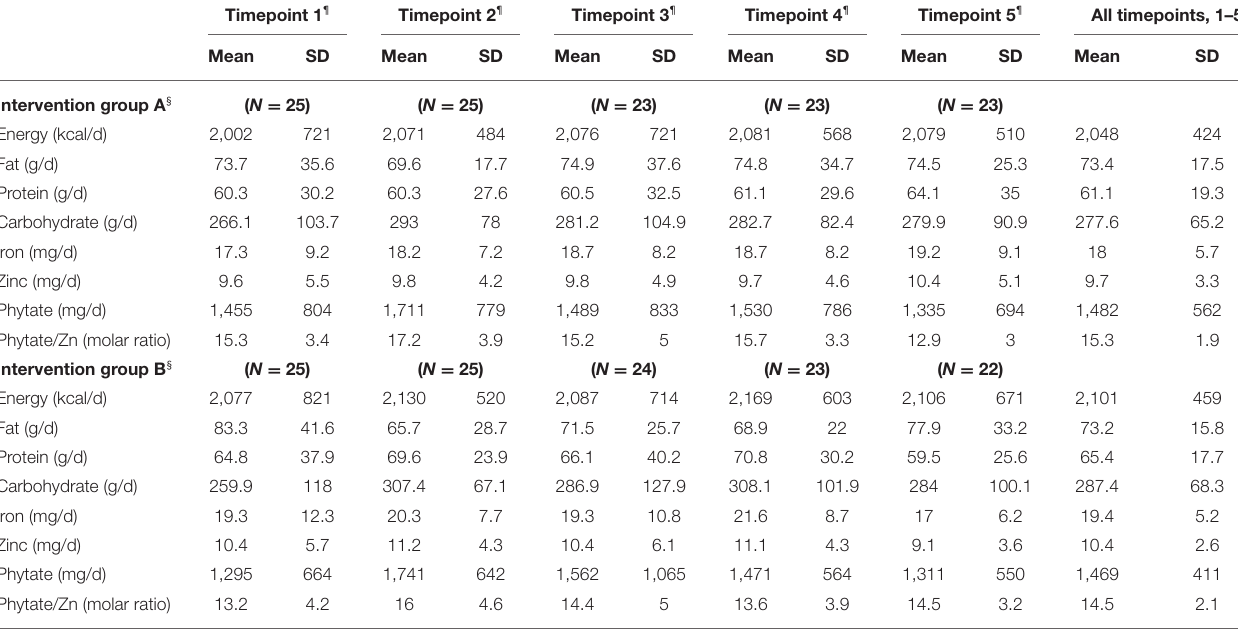
TABLE 1 | Daily dietary nutrient and phytate intake during the randomised controlled trial. Timepoint 1 ¶ Timepoint 2 ¶ Timepoint 3 ¶ Timepoint 4 ¶ Timepoint 5 ¶ All timepoints,